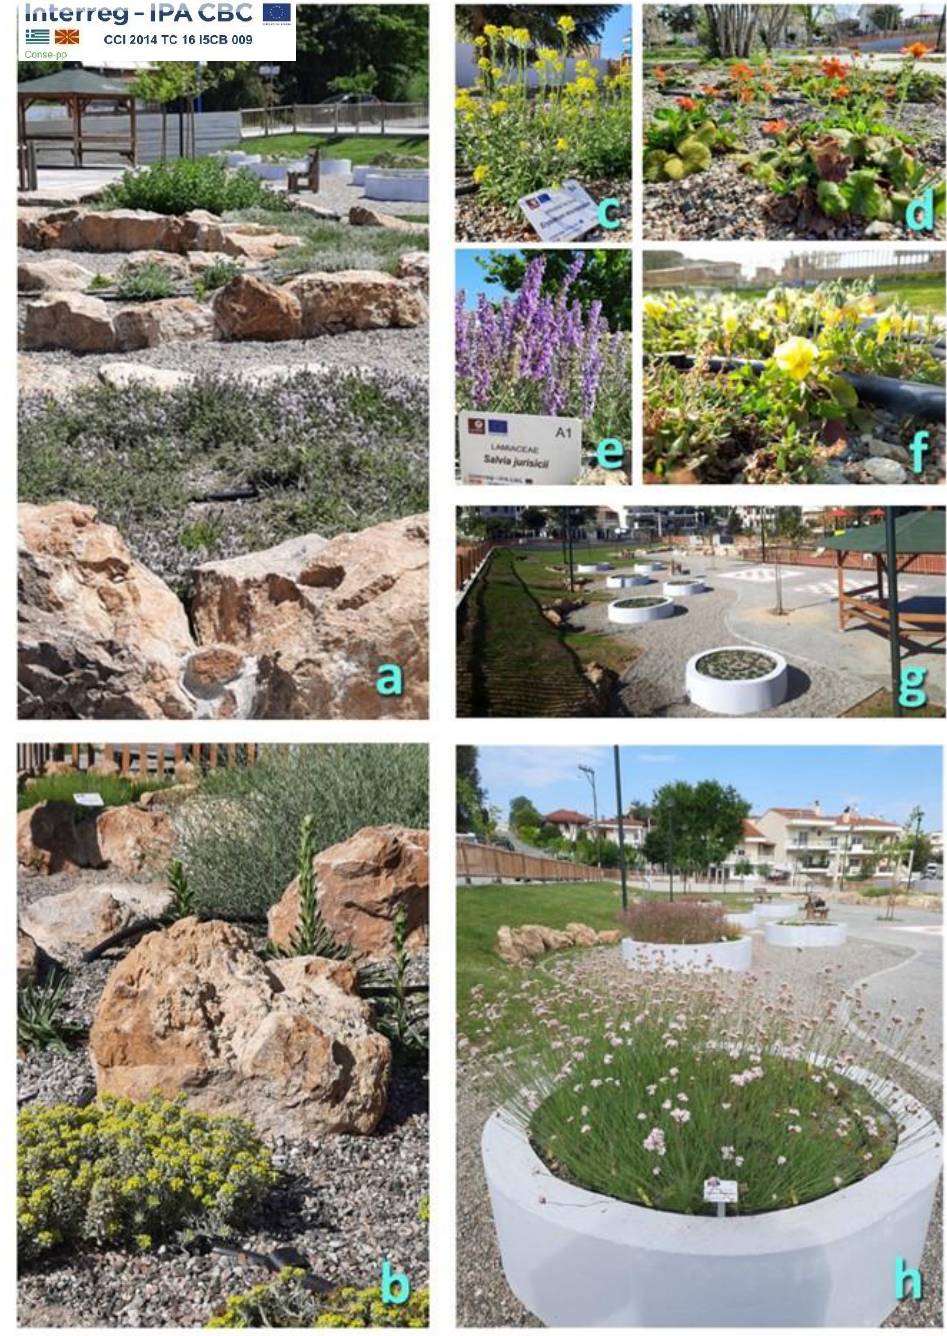
Figure 11. Representative views of different plants displayed at the grounds of the Botanical Aware- ness Public Park (BAPP) which was created in Kardia, Munipalicity of Thermi, metropolitan Thes- saloniki, Northern Greece. ( a ) Priority plants with medicinal and/or aromatic value; ( b ) Erysimum microstylum (Prority B4); ( c ) Geum coccineum (Priority B4); ( d ) Salvia jurisicii (Priority A1); ( e ) Viola arsenica (Priority B2); ( f ) Priority plants in circular raised concrete beds; ( g ) Alyssum dorfleri (Priority A1) and Lilium candidum (Priority A2); ( h ) Dianthus stenopetalus (Priority C1).